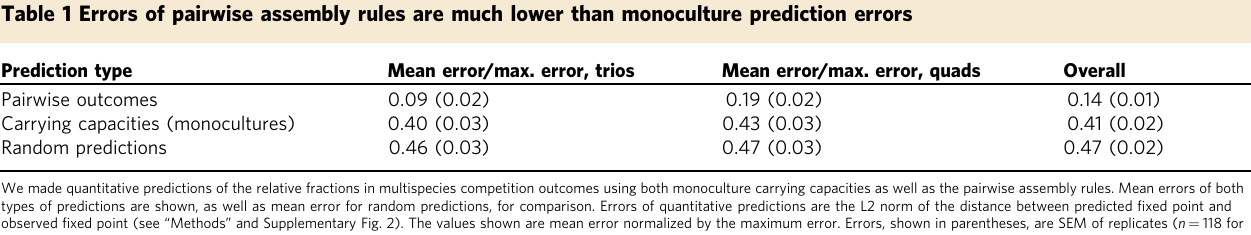
We made quantitative predictions of the relative fractions in multispecies competition outcomes using both monoculture carrying capacities as well as the pairwise assembly rules. Mean errors of both types of predictions are shown, as well as mean error for random predictions, for comparison. Errors of quantitative predictions are the L2 norm of the distance between predicted fi xed point and observed fi xed point (see “ Methods ” and Supplementary Fig. 2). The values shown are mean error normalized by the maximum error. Errors, shown in parentheses, are SEM of replicates ( n = 118 for trios, n = 96 for quads; outcomes of different starting fractions of the same biological replicate were averaged before measuring error, and in the case of bistability, the smaller of the two errors was chosen after averaging outcomes from different starting fractions ending at the same fi nal